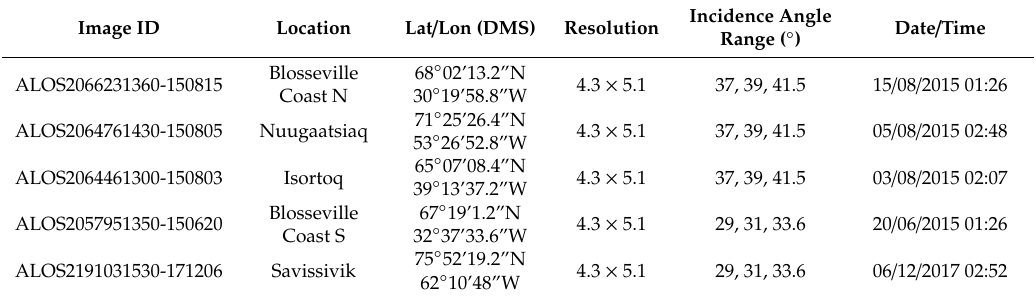
Table 1. ALOS-2 / PALSAR-2 JAXA properties. Centre DMS coordinates are selected for latitude and longitude. Incidence angle range is min, centre and max. Note the ground resolution is for ALOS-2 / PALSAR-2 quad-pol mode. Time is UTC.